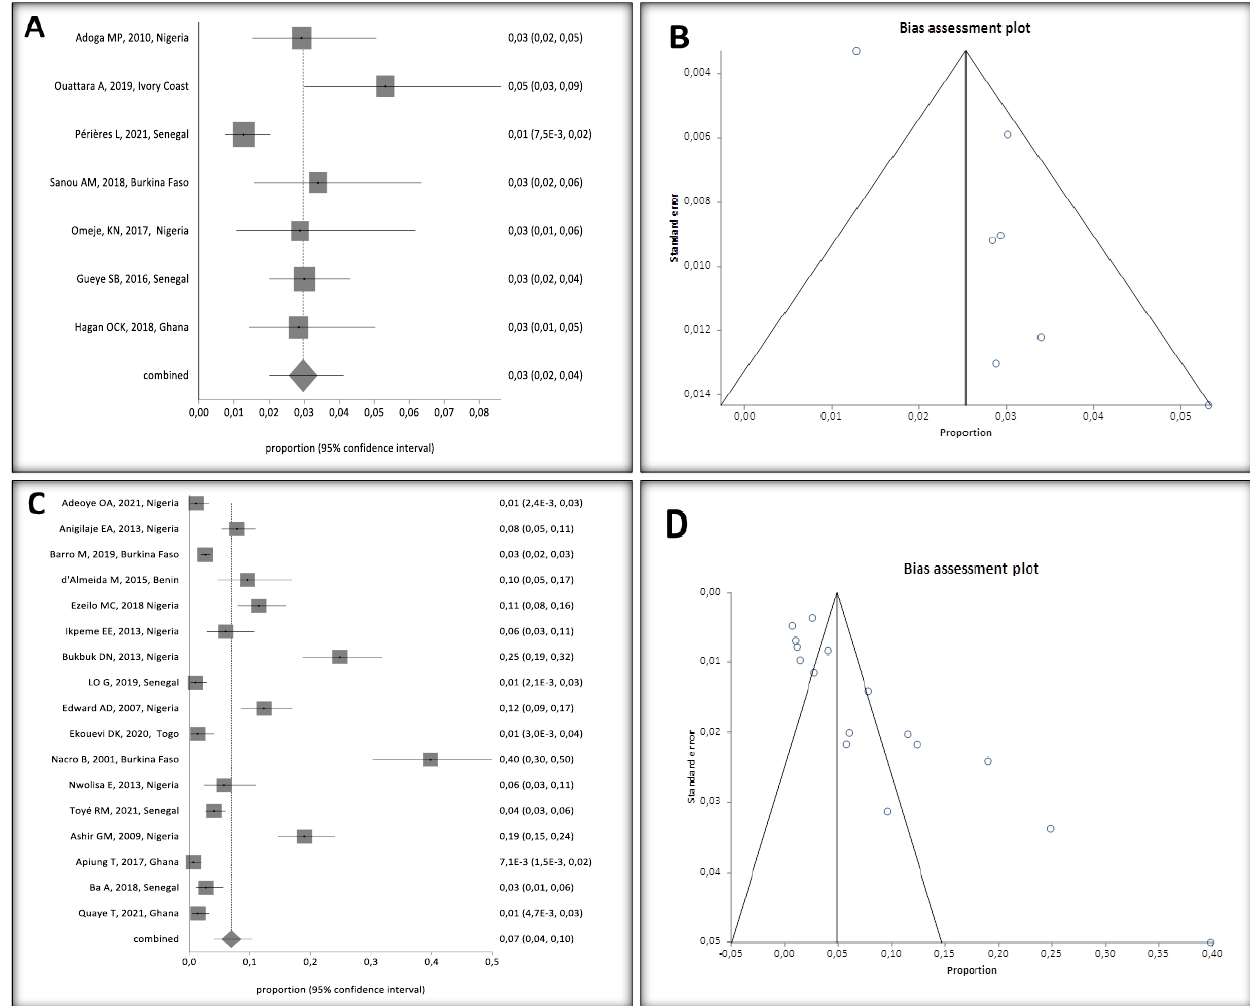
Figure 7. ( A ) Forest Plots of HBV Prevalence in Children, 0 – 16 Years Old, in West Africa, Conducted in Community Settings, ( B ) Heterogeneity in Community Setting Studies, ( C ) Forest Plots of HBV Prevalence in Hospital Settings, and ( D ) Heterogeneity in Hospital Setting Studies [24 – 26,28 – 34,36 – 41,43 – 48]. A black square represents the HBV prevalence in the forest plot. The square position represents the prevalence in each study in the meta-analysis .